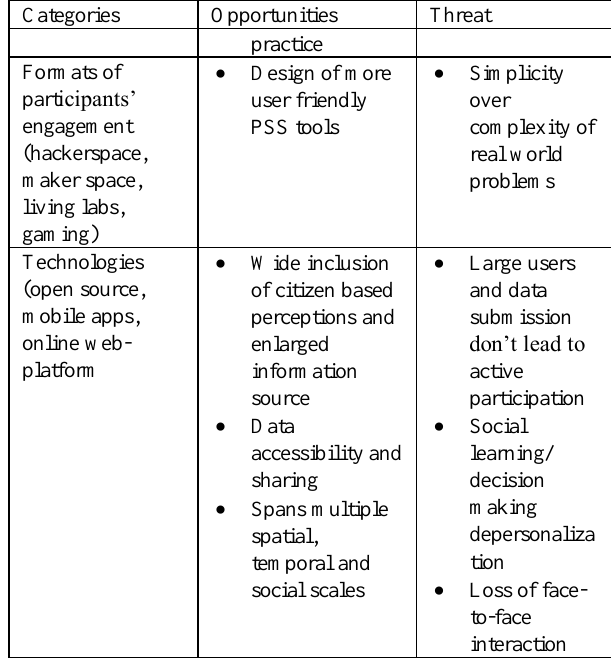
Table 1. SWOT on each